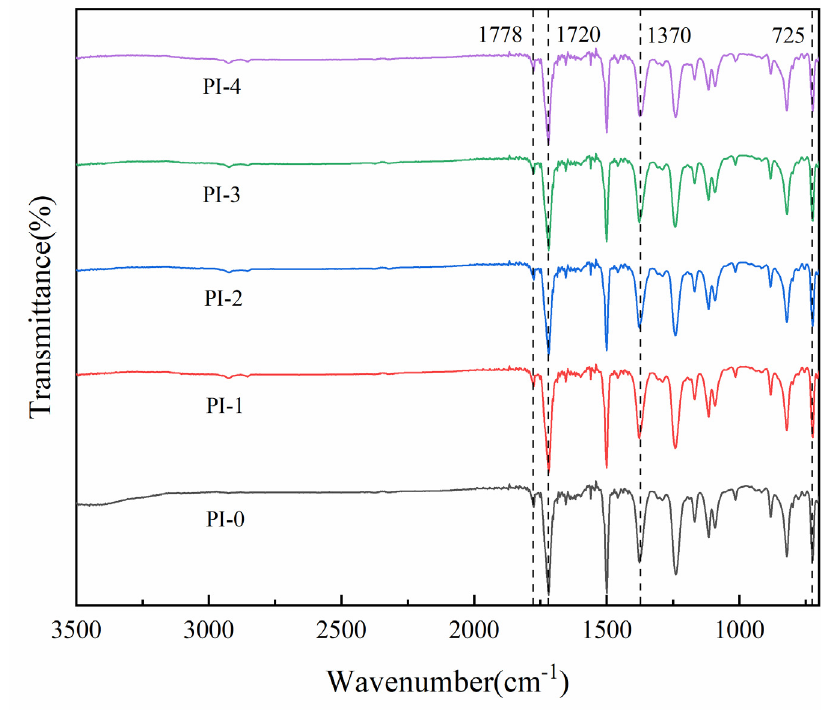
Figure 2. FTIR spectra of the PI films.